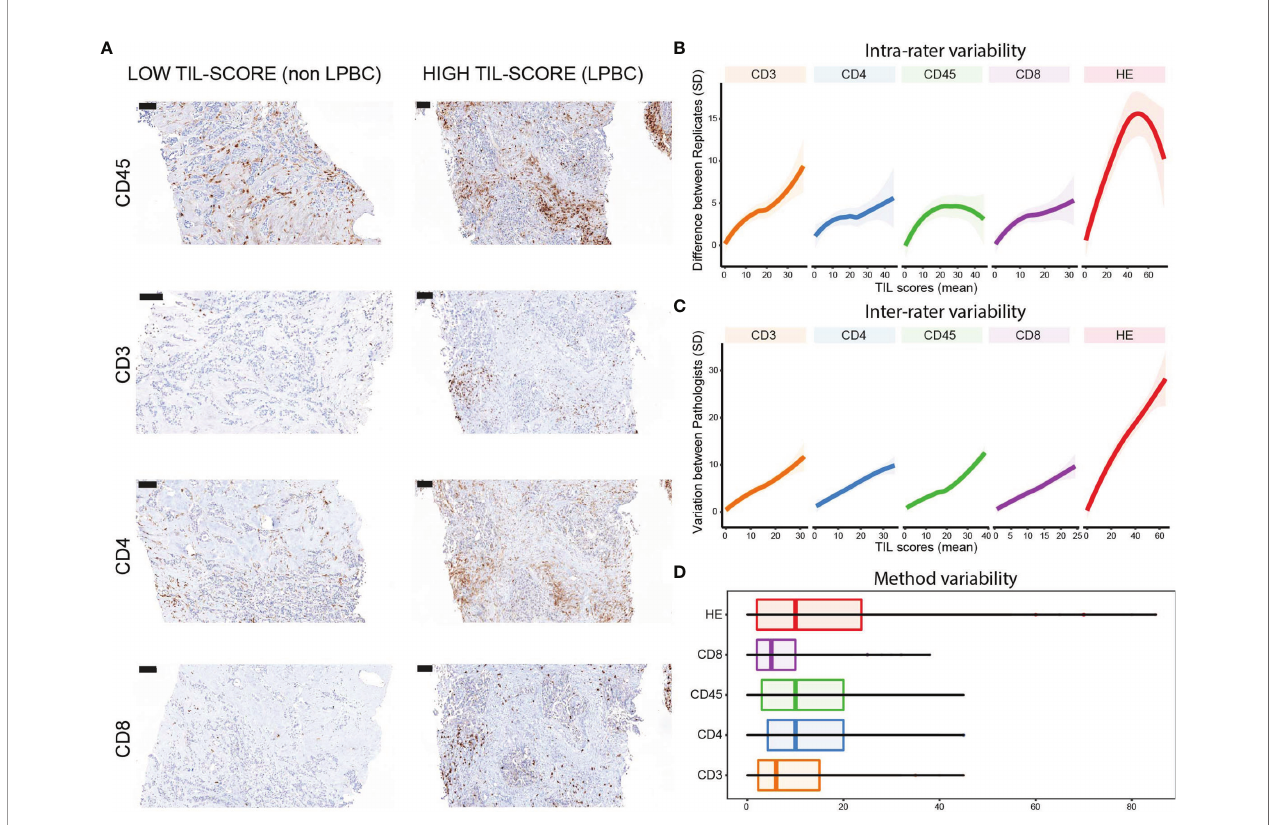
FIGURE 2 | Intra- and interrater variability of TIL scores determined on antibody- and HE-stained tissue sections. (A) Staining of breast cancer tissue sections with antibodies speci fi c for CD45, CD3, CD4, or CD8. Scale bars: 100 µm. (B) Graph showing intrarater variability. (C) Graph showing interrater variability. (D) Box plots showing method variability. Data information: 37 biopsies were stained with HE or immune cell-speci fi c antibodies and scored twice with a washout period of 3 days by three independent pathologists. In (B , C) , data are presented as mean ± con fi dence interval of